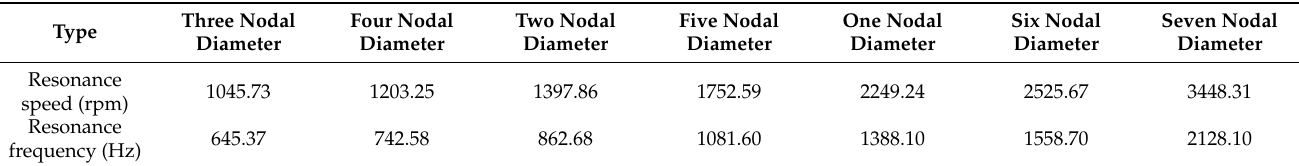
Table 4. Traveling wave frequency and speed of L-shaped flexible ring